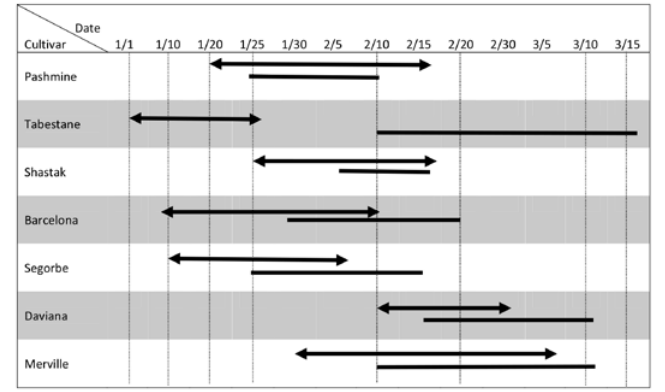
Fig. 1 - Period of bud break and female and male bloom of 10 hazelnut cultivars. Male bloom; female